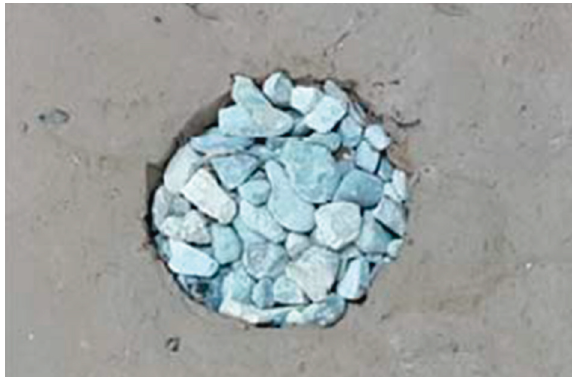
Figure 1: Sample of a stone column made in laboratory conditions